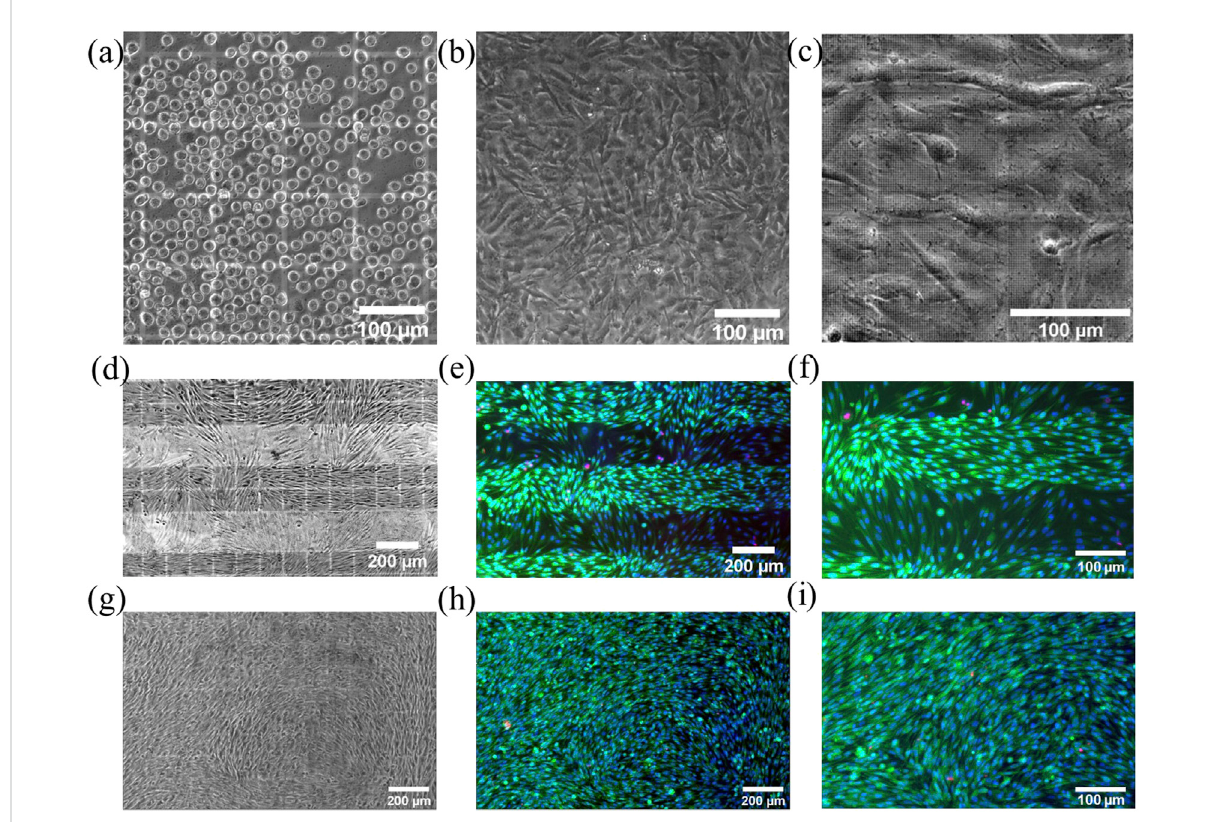
FIGURE 10 Microscopic views into the closed chip showing muMEC cells on top of gelatin coated Si x N y nanoporous membrane. (A) Directly after self- loading seeding and (B) after 1 day of pre-cultivation. Supported by strong capillary forces in the microchannel and the large inlets from the chip edge, muMEC cells are equally distributed and can grow as a con fl uent monolayer. (C) Zoom-in reveals the nanopore areas in the Si x N y membrane and more details of the cells. Bright fi eld images taken after pre-cultivation and 3 days of dynamic chip cultivation (D,G) together with corresponding fl uorescence imageswith live/dead staining(green/red)andbluecellnucleus staining (E,F,H,I) .Shown isthegrowth on continuously nanoporous membranes (D – F) and on membranes with only nanoporous sections (G – I) . The zoom-ins (F,I) show the formation of a con fl uent cell layers only on nanoporous